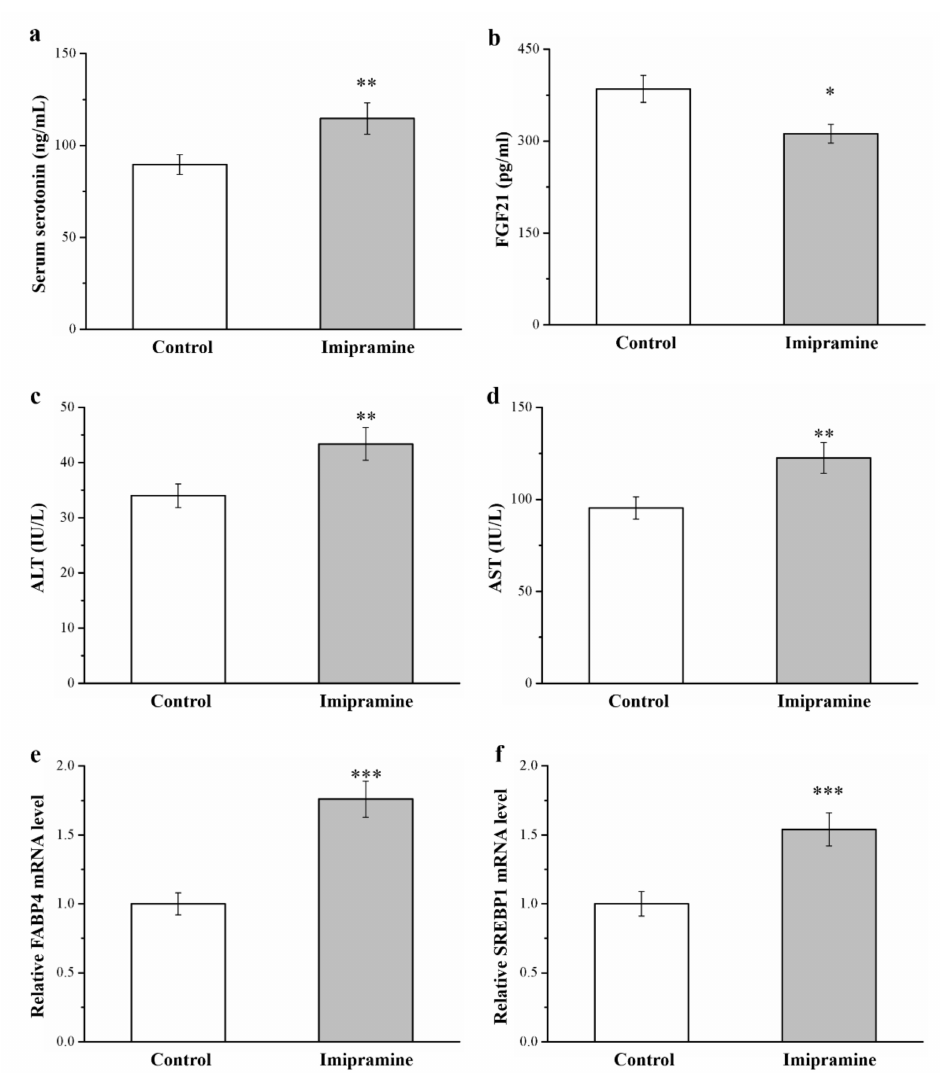
Figure 4. Effects of imipramine on ( a ) serum serotonin levels, ( b ) serum fibroblast growth factor-21 (FGF21) levels, ( c ) serum alanine aminotransferase (ALT) levels, ( d ) serum aspartate aminotransferase (AST) levels, and hepatic mRNA levels of ( e ) FABP4 and ( f ) SREBP1 measured in HFD-fed control and obese imipramine-treated mice. Data are in the form of mean ± standard deviation ( n = 8). * p < 0.05; ** p < 0.01; *** p <